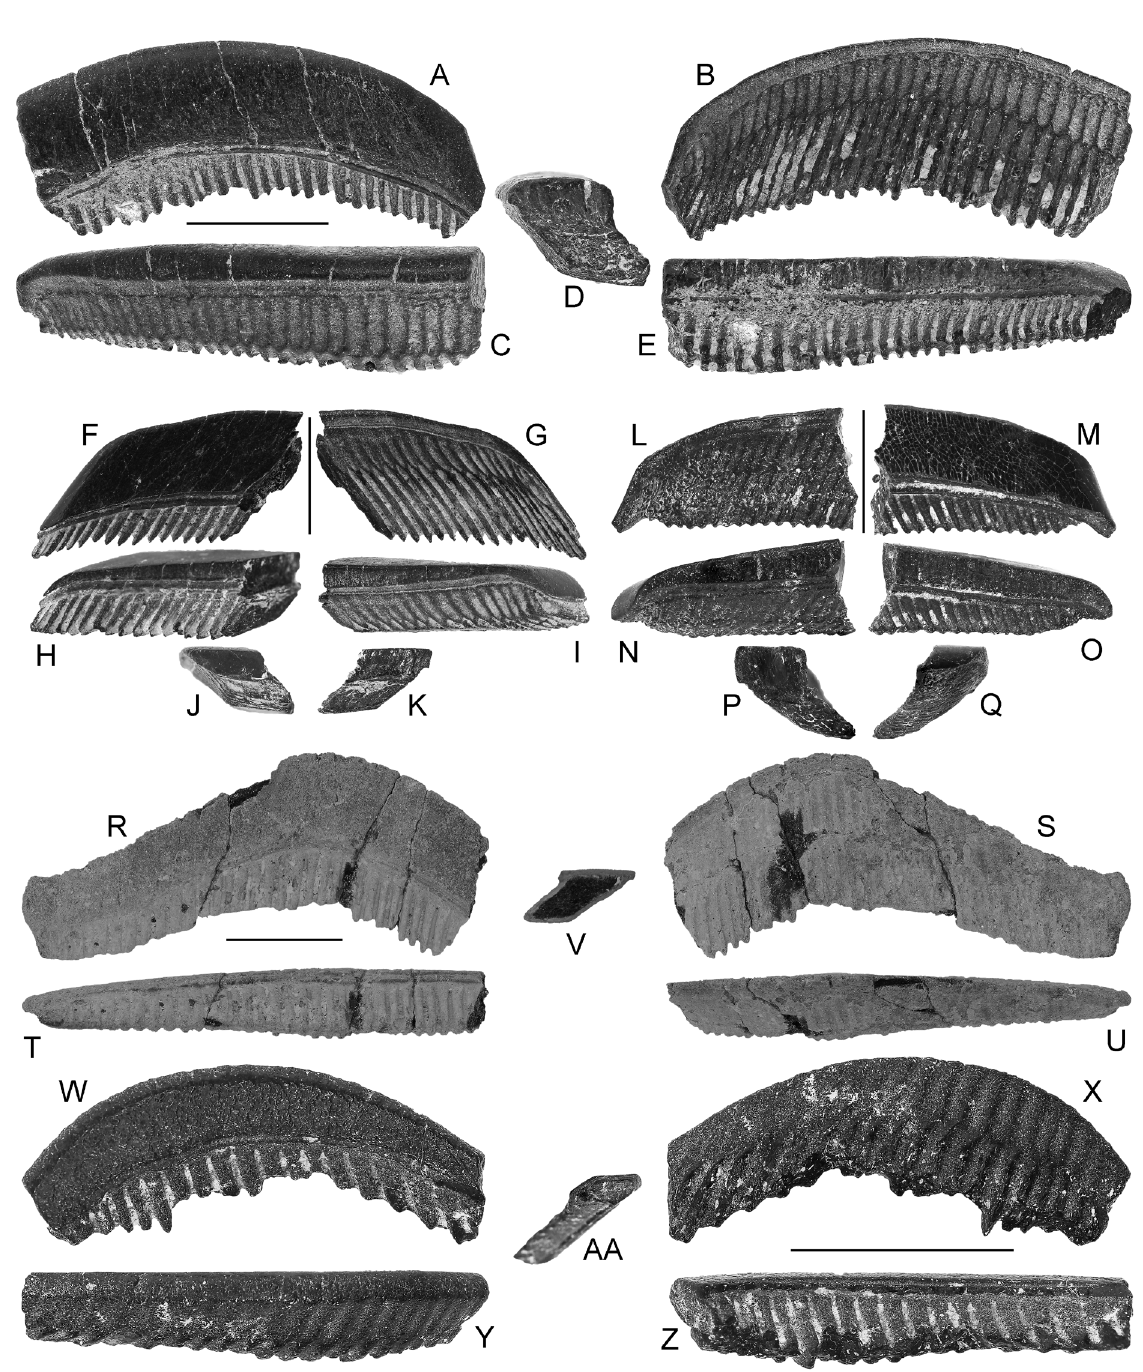
Fig. 44. Aetobatus sp., teeth. A–E . MSC 37150, lower median tooth, Tallahatta/Lisbon formation contact zone, courtesy of Bruce Relihan. A . Oral view. B . Basal view. C . Labial view. D . Profile view. E . Lingual view. F–K . MSC 37330.1, median tooth, basal Lisbon Formation. F . Oral view. G . Basal view. H . Lingual view. I . Labial view. J . Distal view. K . Mesial view. L–Q . MSC 37330.2, median tooth, basal Lisbon Formation. L . Basal view. M . Oral view. N . Labial view. O . Lingual view. P . Profile view. Q . Distal view. R–V . SC2012.47.23, lower median tooth, basal Lisbon Formation. R . Oral view. S . Basal view. T . Lingual view. U . Labial view. V . Profile view. W–AA . SC2012.47.24, lower median tooth, basal Lisbon Formation. W . Oral view. X . Basal view. Y . Labial view. Z . Lingual view. AA . Profile view. Scale bars = 1